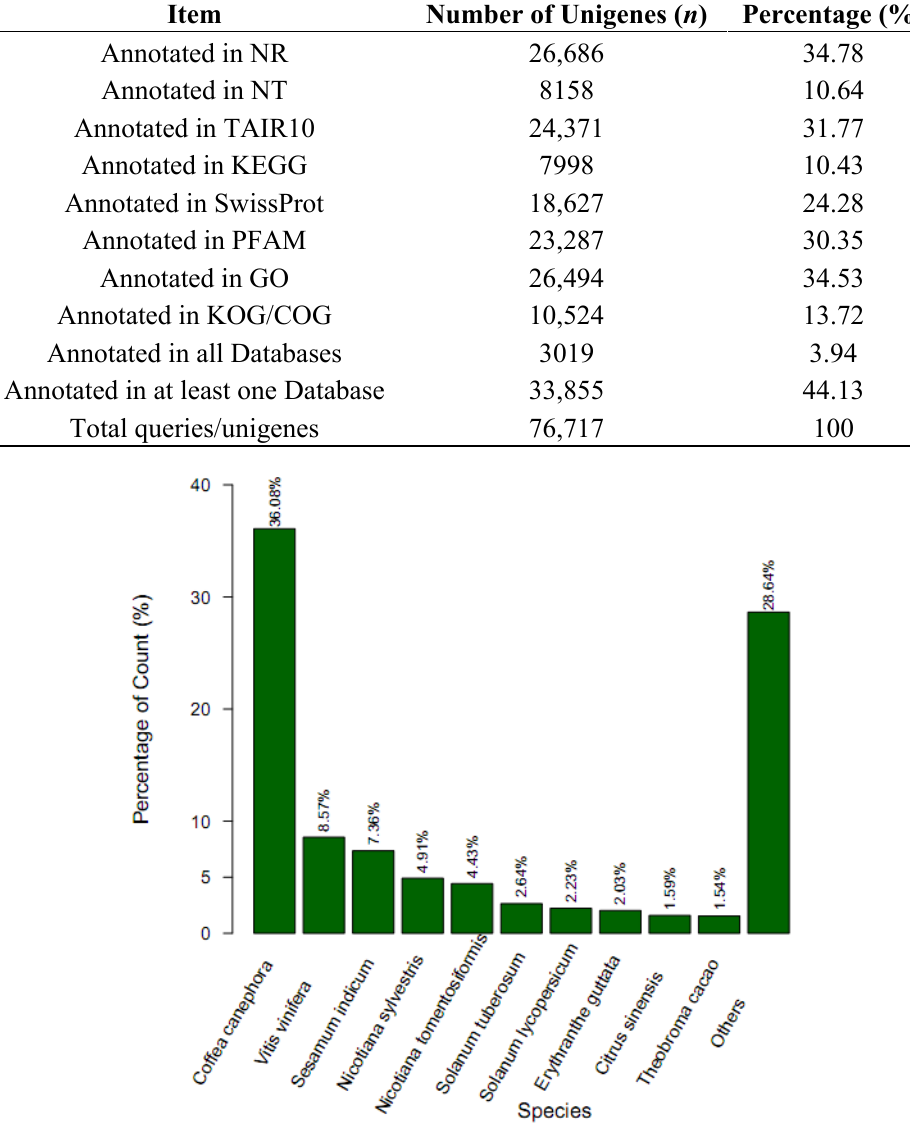
Figure 2. Species distribution of the top BLAST (Basic Local Alignment Search Tool) hits for each unigene against NR (Non-redundant)